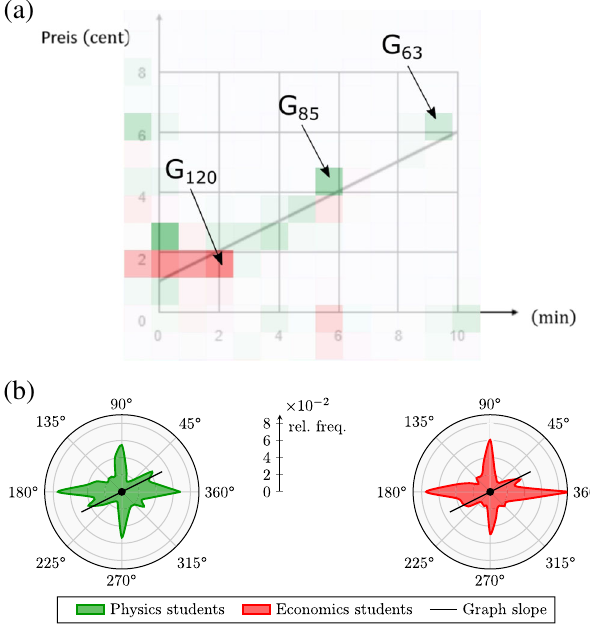
FIG. 9. Analysis of visual attention and saccadic eye move- ments for the quantitative question on graph slope in the context of finance. Students had to determine the cost per minute from the graph. For more details, please refer to the caption of Fig. 8.